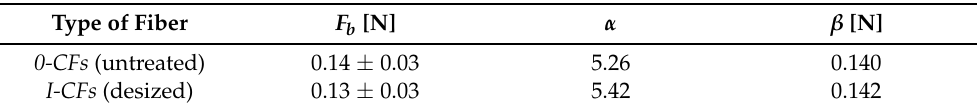
Table 2. Summary of results from tensile tests for the as-received and treated carbon fibers: failure load F b and Weibull parameters α and β